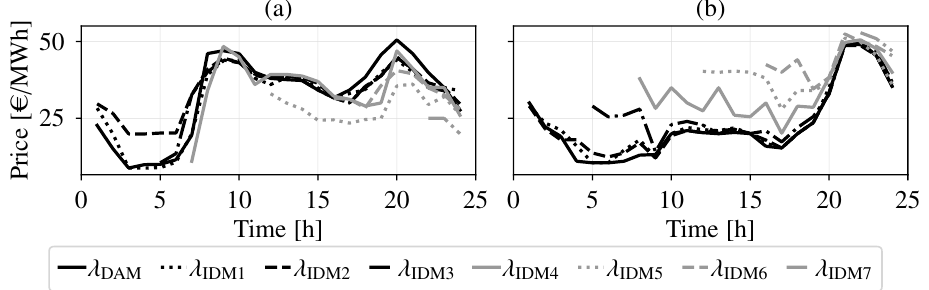
Figure 6. DAM and IDM prices on ( a ) clear day, ( b ) cloudy day.